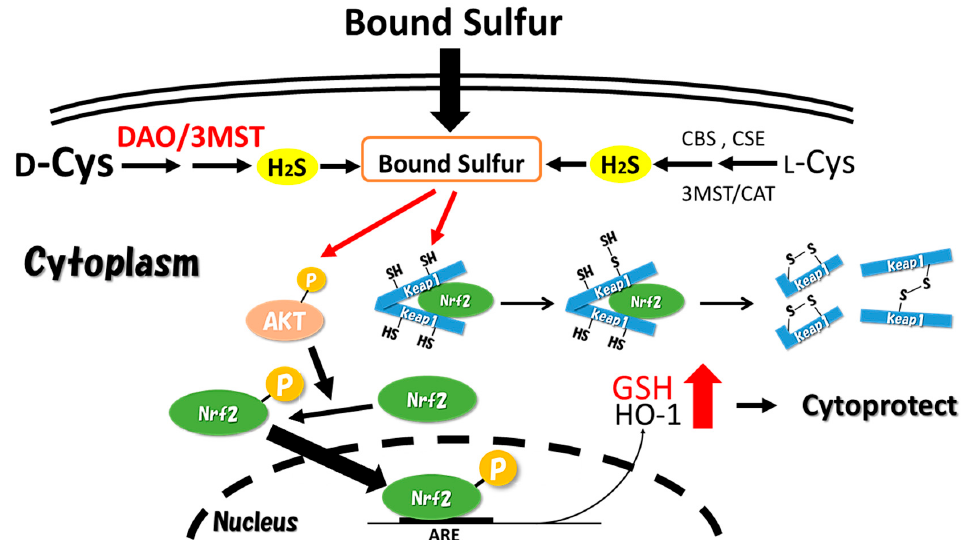
Figure 3. Bound sulfur activates the nuclear factor erythroid related factor 2 (Nrf2) system through a structural change of Kelch-like ECH-associated protein 1 (Keap1) and promotion of the AKT/phosphoinositide 3-kinase (PI3K) signaling pathway. ARE: antioxidant response element; GSH: glutathione; HO-1: heme oxygenase 1.